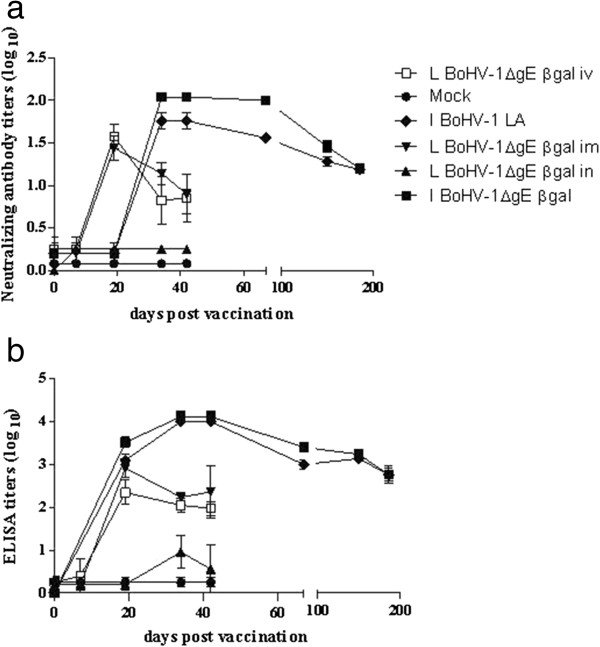
Antibody response to BoHV-1 observed in vaccinated cattle. BoHV-1-specific antibody response detected by ELISA (b) or virus neutralization assay (a) in animals vaccinated either with inactivated (I) or live attenuated vaccine (L) formulated with BoHV-1ΔgEβgal or BoHV-1 LA viruses. Live attenuated vaccines were administered by intranasal (in), intramuscular (im) or intravenous (iv) route. Neutralizing antibody titers are expressed as log10 of the reciprocal value of the serum dilution giving protection to CPE. Averages and SEM of the titers obtained for each group are shown for each time point. Antibody titers measured by ELISA are expressed as log10 of the reciprocal value of the serum dilution giving an A405 of 40% of the positive control. Each point represents the mean titer and SEM of five animals.